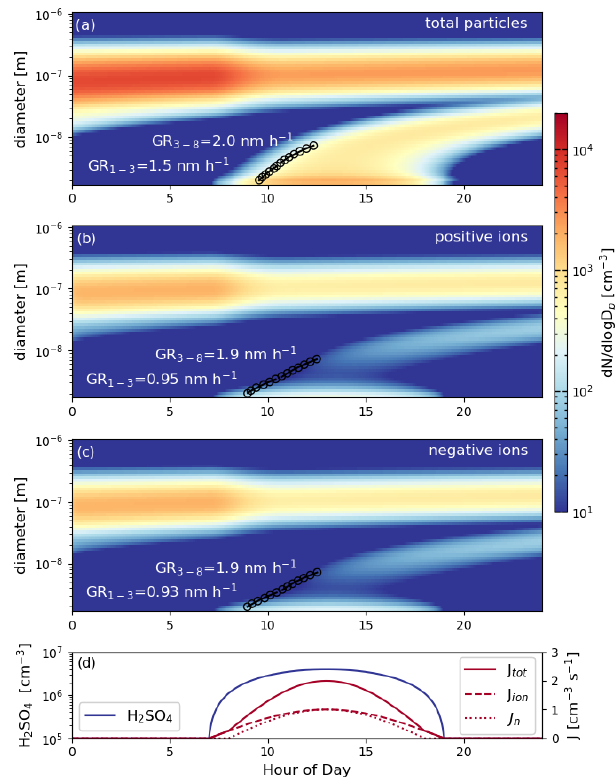
Figure 4. Model results based on Leppä et al. (2009), with the ion-induced nucleation starting 1h earlier than the neutral pathway, as suggested by the conceptual approach of Gonser et al. (2014). Panel (a) corresponds to the total particle-size distribution, and pan- els (b) and (c) are the (positive and negative) ion-size distributions. The calculated apparent growth rate with the ion-UHMA model (black scatters) has also been plotted. Panel (d) corresponds to the evolution of the nucleation rate of the total particle ( J tot ), the ions ( J ion ) and the neutral particles ( J n